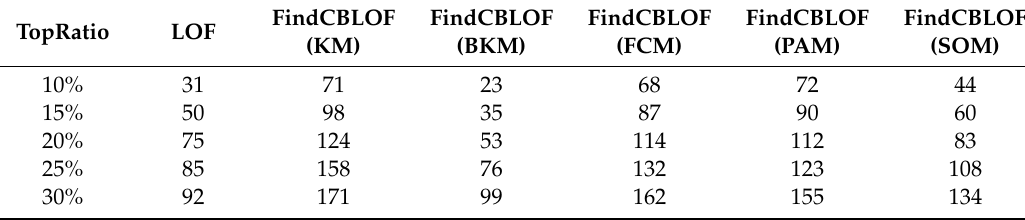
Table 6. Number of Detected Outliers for the Cardio Dataset (FindCBLOF).